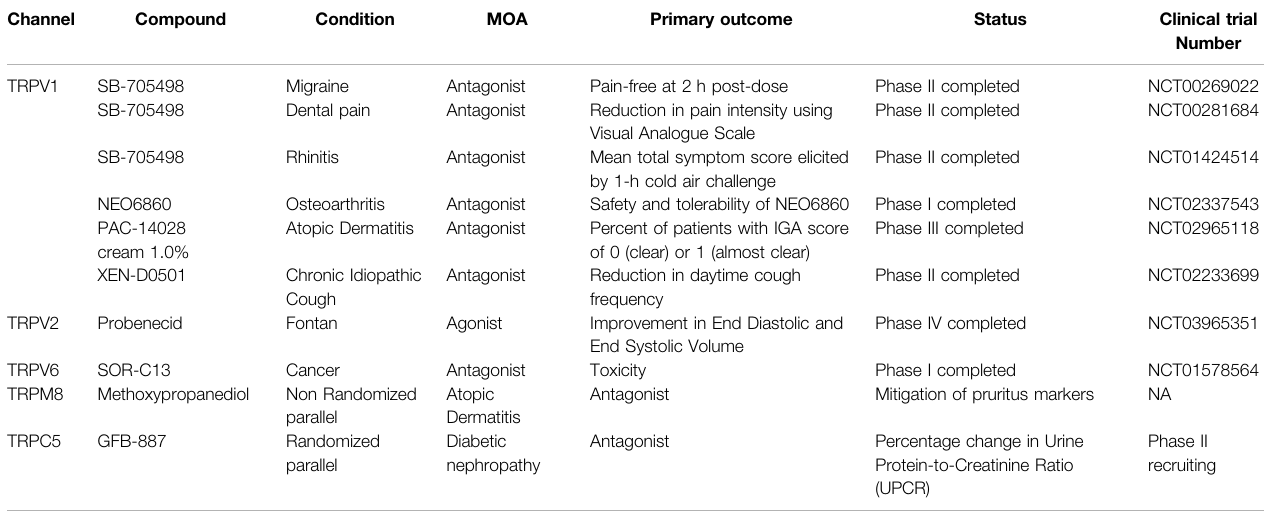
TABLE 2 | Compounds under clinical trials to target the transient receptor potential channels (TRP ion channels). The information was retrieved from the ClinicalTrials.gov database. Channel